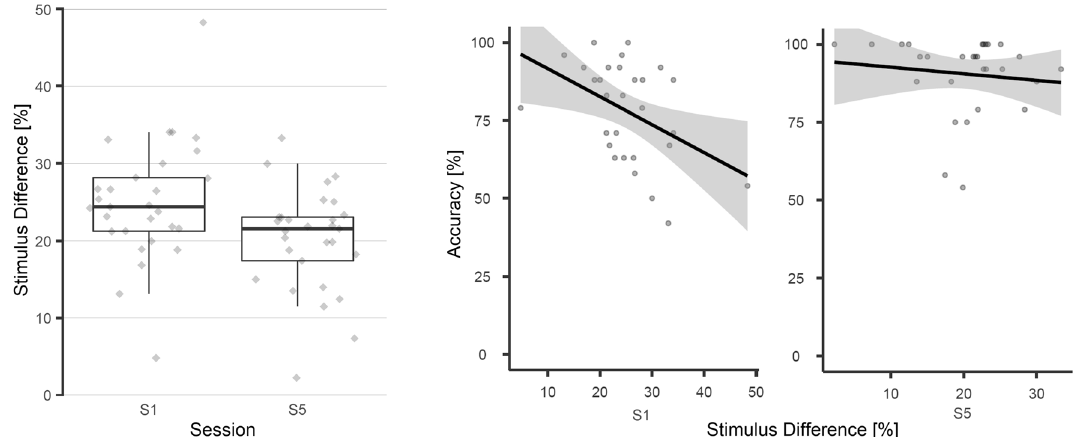
Figure 5. Analysis of the somatosensory sensitivity. After training, participants were able to discriminate between smaller stimulus differences, indicated by significantly lower sensory thresholds. There was a negative correlation between the sensory thresholds and accuracy in session one, but not session